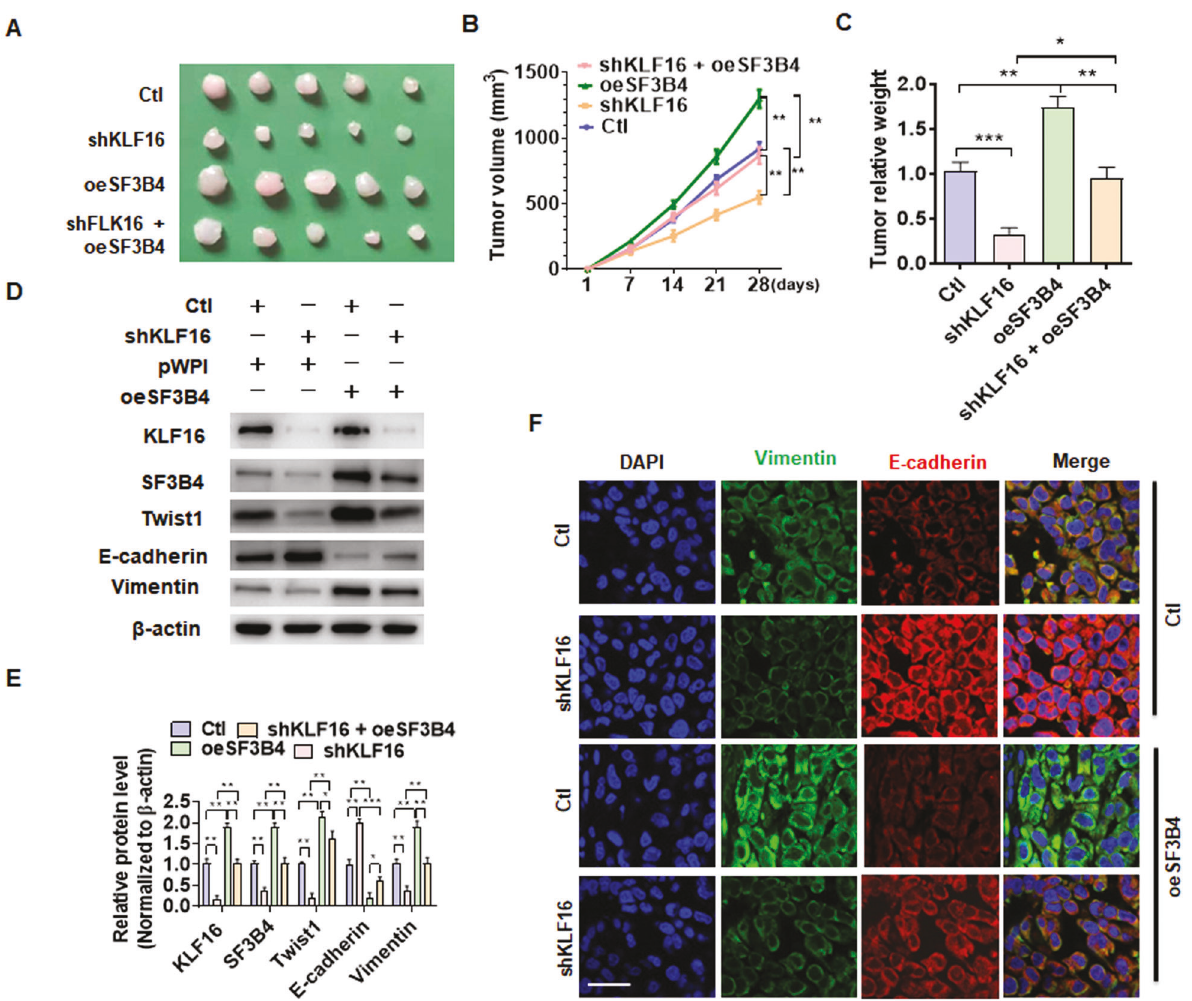
Fig. 8 SF3B4-KLF16-Twist1 axis promotes the progression of ccRCC in vivo. A Caki-1 cells, engineered to stably knock down KLF16 or stably overexpress SF3B4, separately or together, were implanted into nude mice to establish xenograft tumors. The tumor sizes in each group were presented after 28 days. B Tumor volumes were measured by direct measurement with calipers. C Xenograft tumor wet weight was determined after the resection of tumors. D The expression of SF3B4, KLF16, Twist1, E-cadherin, and vimentin was examined in xenograft tumors by western blotting. E Quantitative analysis of B . F Double immuno fl uorescence staining of vimentin and E-cadherin in xenograft tumors. Scale bar = 20 μ m. All data are expressed as the mean ± SEM of three independent experiments. * P < 0.05, ** P < 0.01, *** P < 0.001 vs. their corresponding